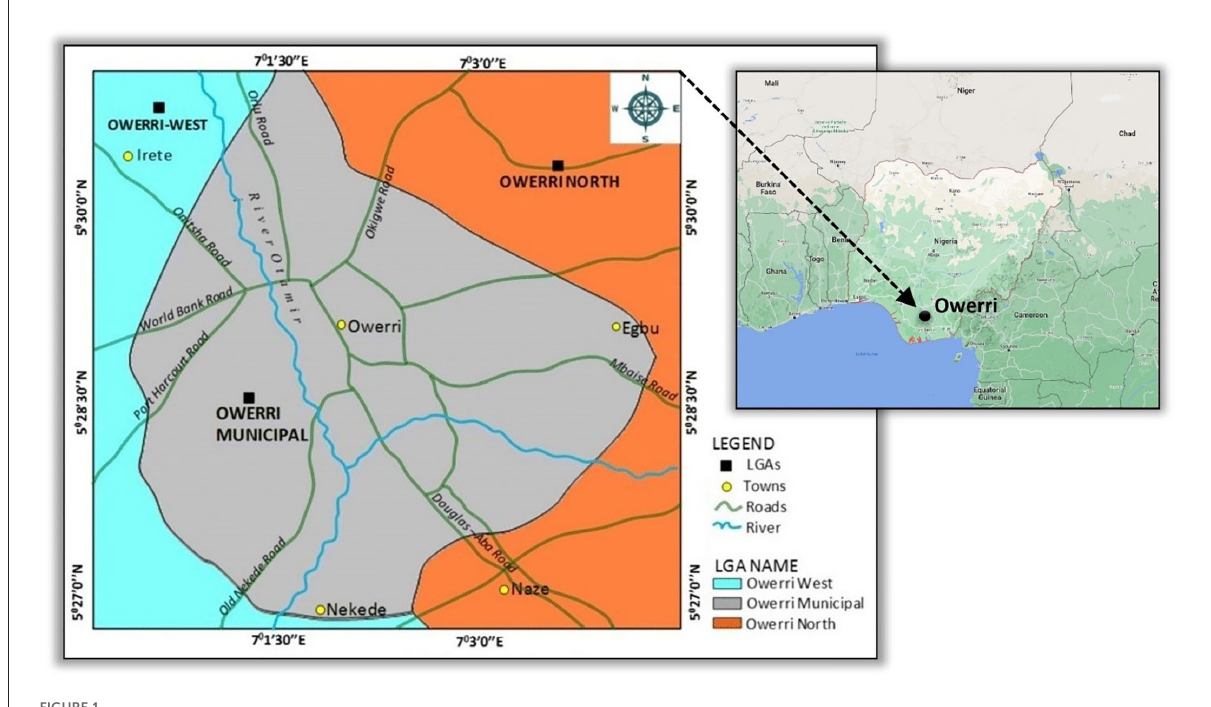
FIGURE1 Location of the study area, adapted from Google Maps